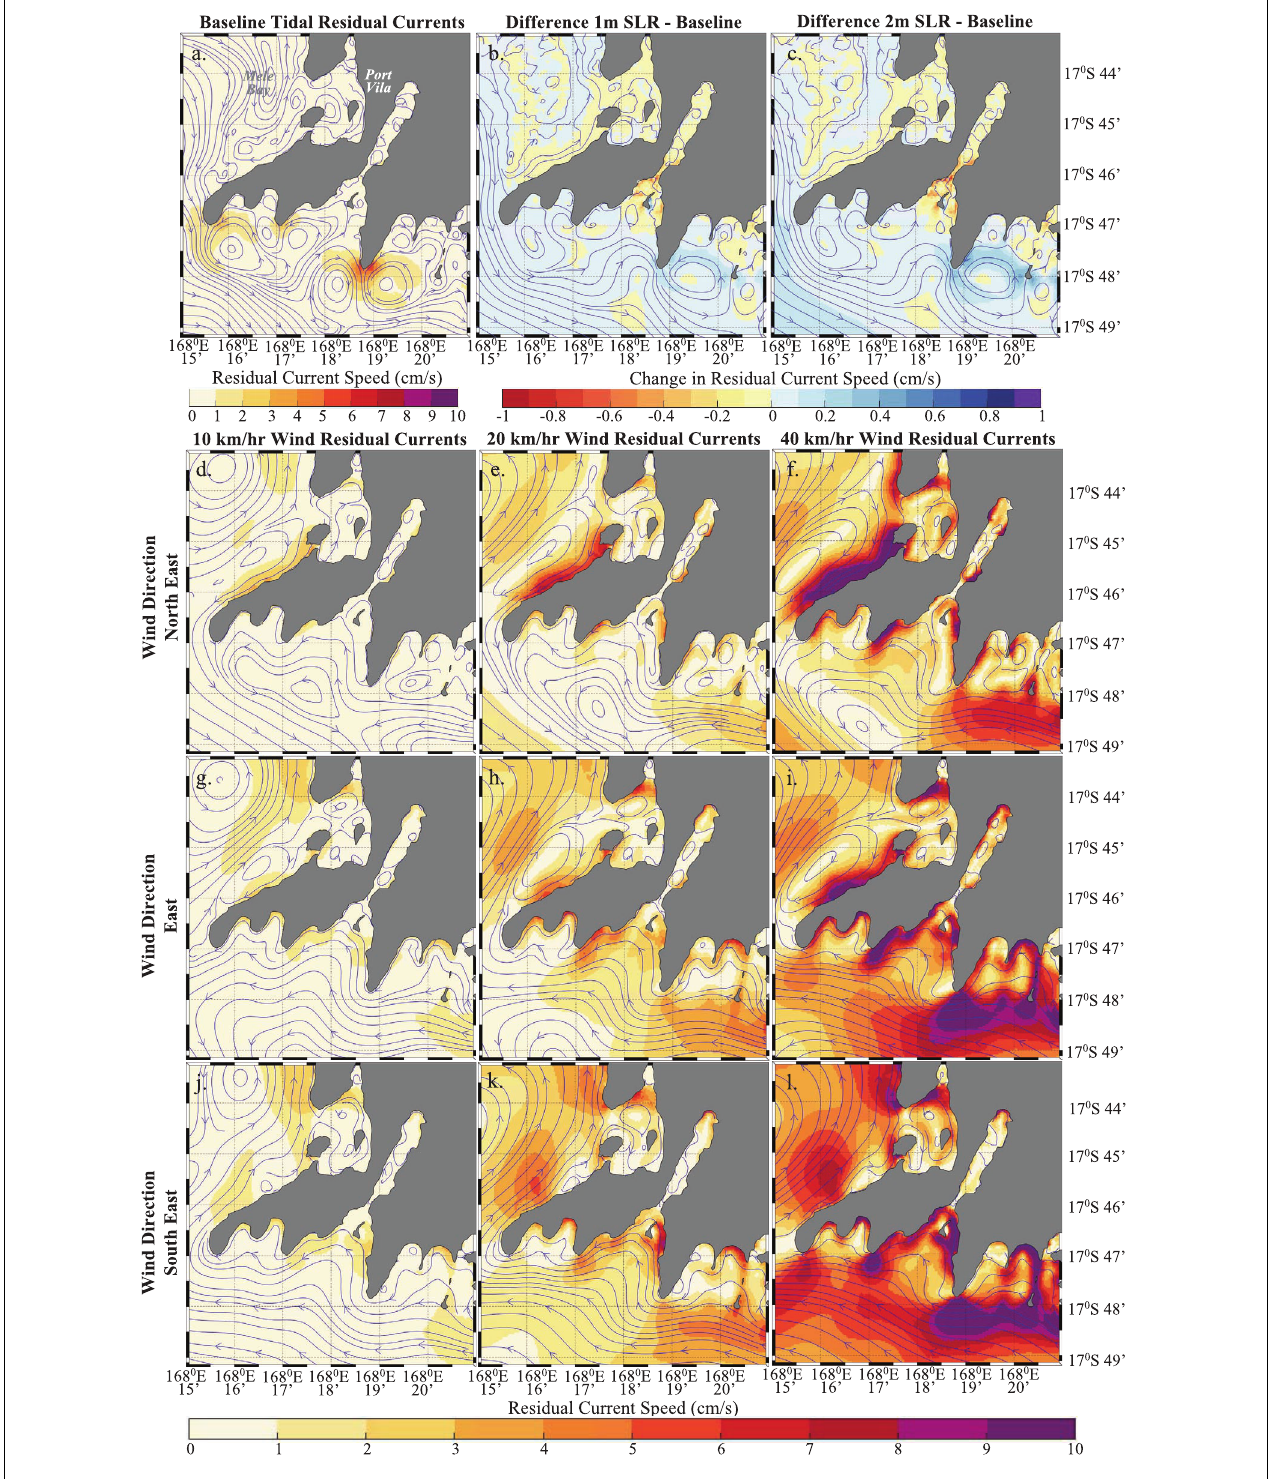
FIGURE 10 | Tidal residual current speeds, with current patterns indicated by streamlines, focussing on Erakor Lagoon, southwest Efate Island (a) . Change in residual current speeds (cm/s) and patterns under 1 m SLR (b) and 2 m SLR (c) . Wind residual current speeds (cm/s) and patterns under 10 km/h (d) , 20 km/h (e) , and 40 km/h (f) northeast winds. Wind residual current speeds (cm/s) and patterns under 10 km/h (g) , 20 km/h (h) , and 40 km/h (i) east winds. Wind residual current speeds (cm/s) and patterns under 10 km/h (j) , 20 km/h (k) , and 40 km/h (l) southeast winds. Latitudes are displayed to the right of panels (c,f,i,l) . Longitude for all panels are displayed below panels (a–c,j–l)